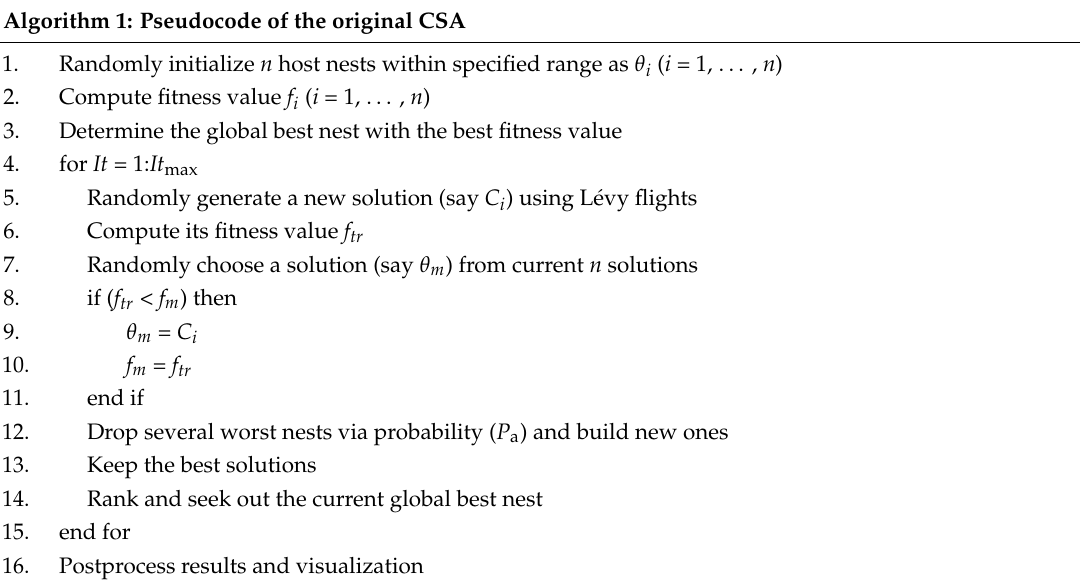
Algorithm 1: Pseudocode of the original